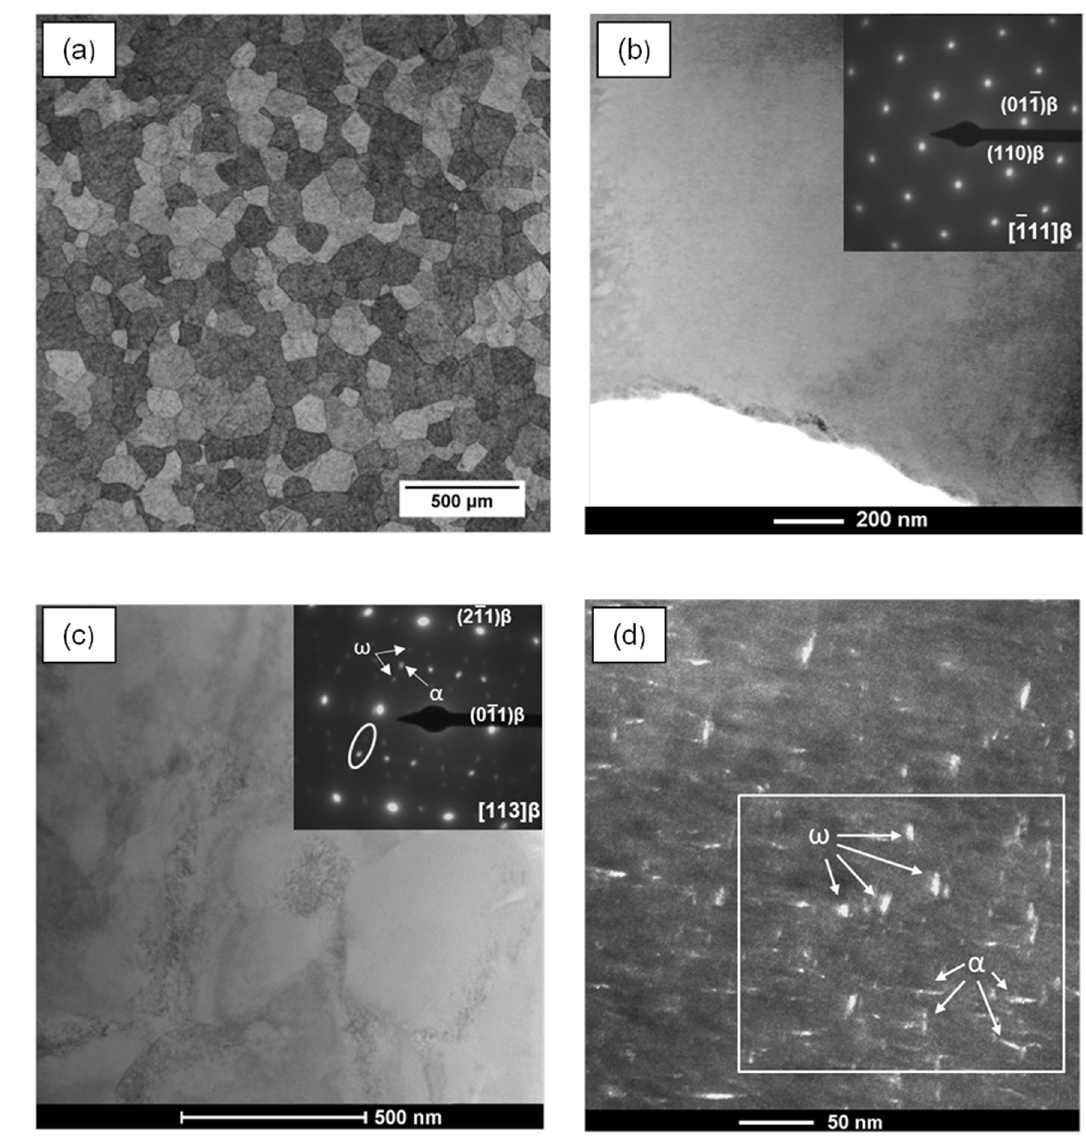
Figure 3. Micrographs of the Ti-35Nb-7Zr-5Ta specimens: (a) OM and (b) TEM bright-field images (and the corresponding SAD pattern) of the solution treated (ST) specimen; (c) TEM bright-field image (and the corresponding SAD pattern) and (d) dark-field image of α and ω phases of the cold rolled plus 20 min aged (CRA-20)